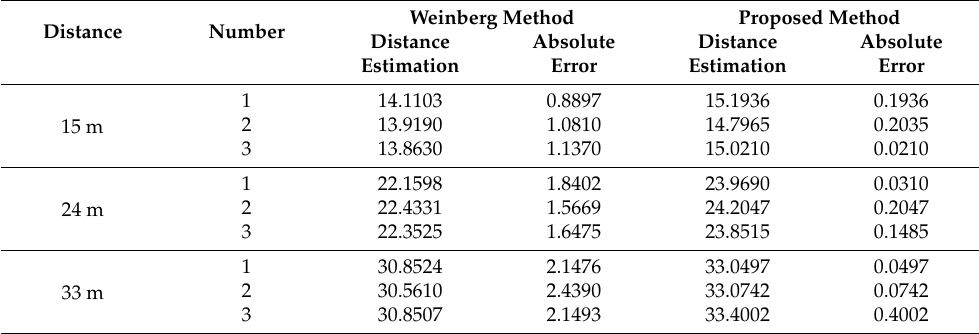
Table 4. Distance estimation and absolute error results between the Weinberg model and the proposed model with different pedestrians and distances